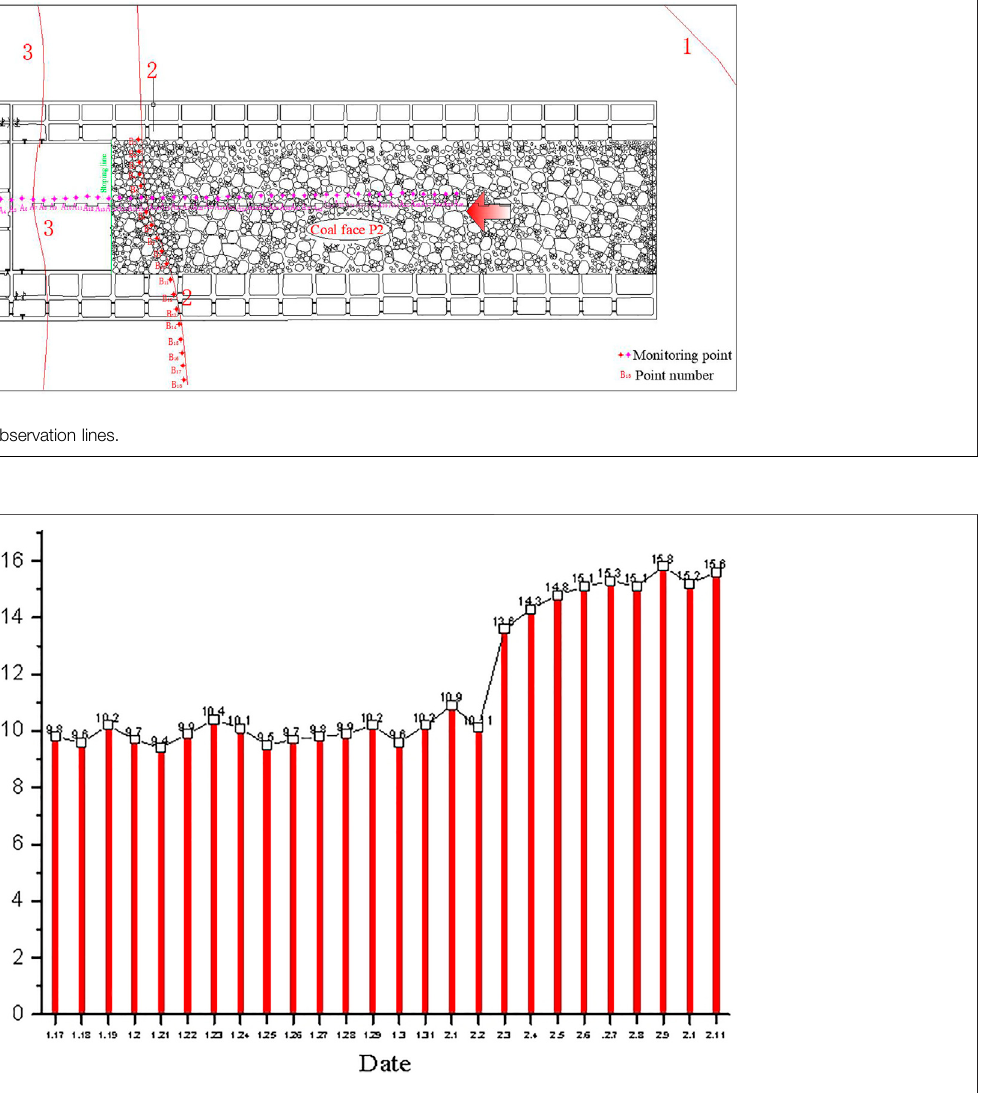
FIGURE 4 | Change of water in fl ow in the working face